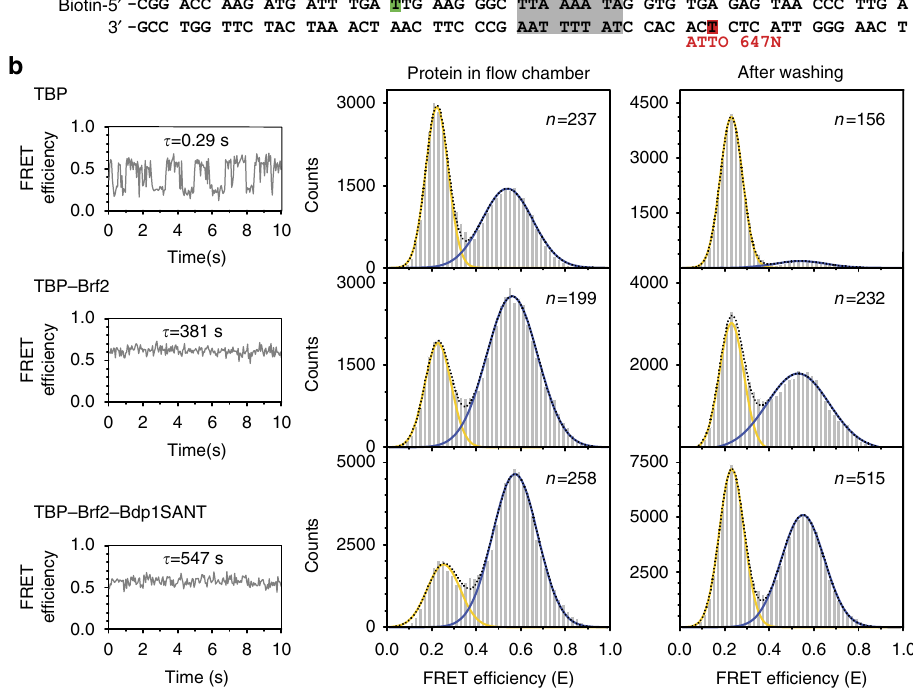
Fig. 5 In fl uence of transcription factors on promoter DNA conformation. a Single-molecule FRET measurements were carried out using a synthetic U6 snRNA promoter. FRET between an internal donor (ATTO 532) and acceptor (ATTO 647N) dye was used as a readout to follow transcription initiation factor-induced bending of the promoter DNA. b Measurements on immobilized molecules were conducted once with the proteins present in the fl ow chamber and after a washing step that removed freely diffusing proteins. A representative intensity – time trace for each measurement is shown depicting the dynamic association and dissociation of TBP (10 nM) with and from the DNA with a complex lifetime of τ = 0.29s. In contrast, addition of Brf2 results in a stable complex characterized by a single high FRET state with a complex lifetime of 381 s. Addition of Bdp1SANT increased the lifetime of the high FRET state to 547 s. FRET ef fi ciency histograms show the distribution between low FRET (free DNA) and high FRET states (bend DNA). The total number of molecules used for each histogram is given as n . Each histogram was fi tted with a single or double Gaussian distribution to determine the mean FRET ef fi ciencies (see Table 2). Each measurement was carried out at least three